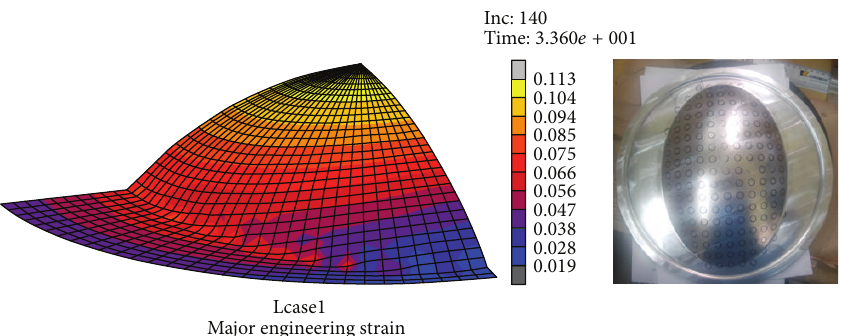
Figure 38: Comparison between maximum deformation in MSC-MARC and pratical results for an elliptical nonprocessed sheet.